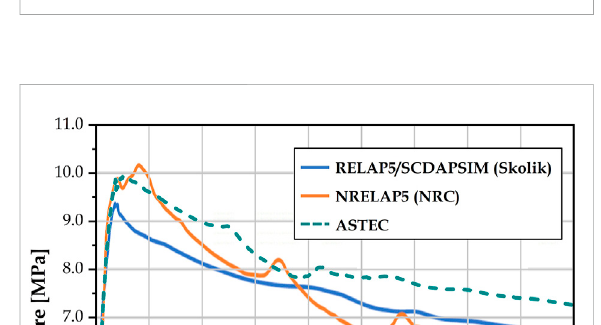
FIGURE 5 Turbine trip transient: Primary pressure.